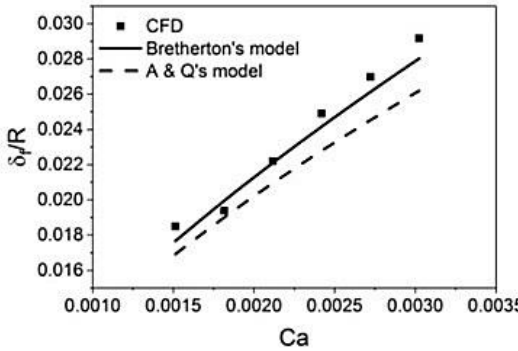
Figure 5. Variation of the continuous phase film thickness with the Capillary number (Do-W